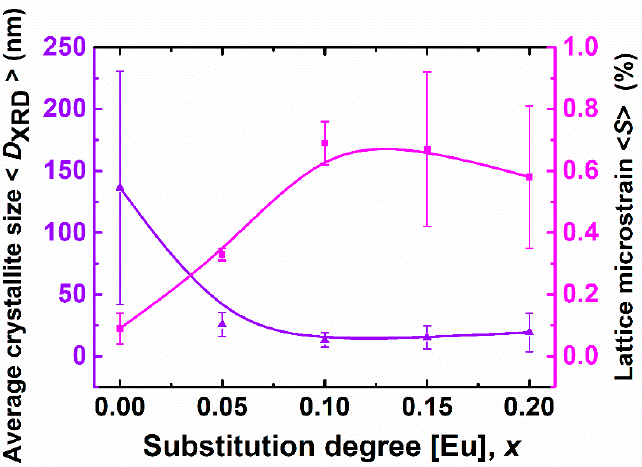
Figure 5. Average crystallite size and lattice microstrain for Bi 1 − x Eu x FeO 3 calcined powders.